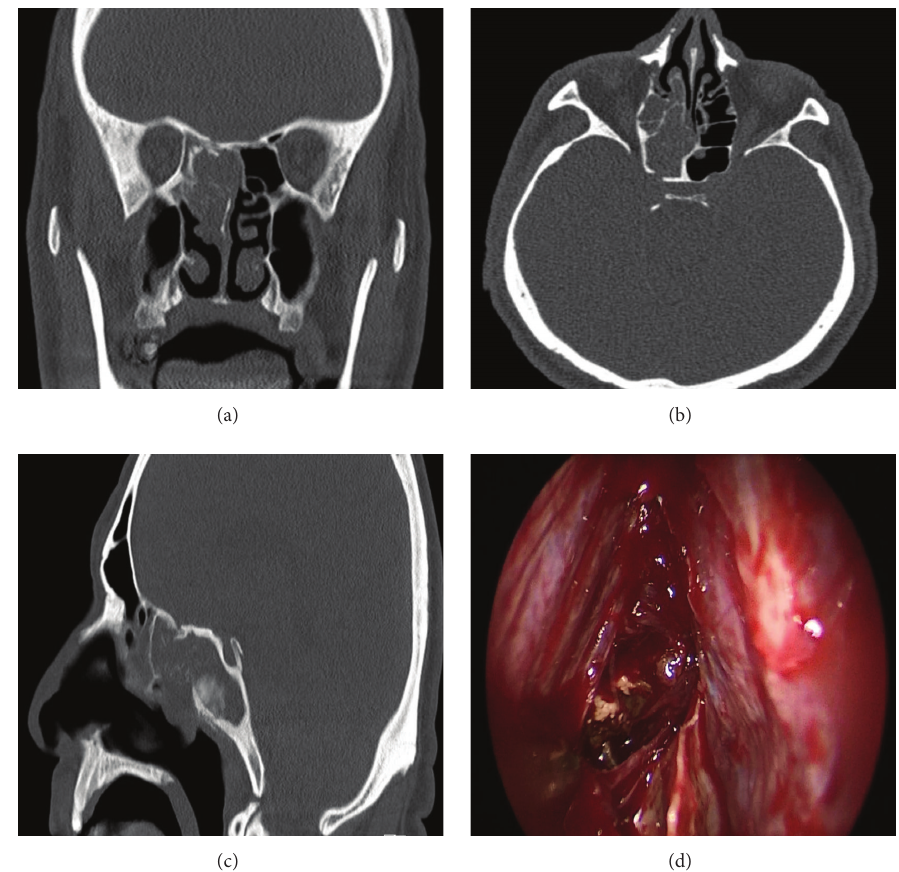
Figure 4: (a, b, and c) Paranasal sinus computed tomography of a hypodense mass filling the right sphenoid sinus (a-coronal, b-axial c-sagittal planes). (d) Endoscopic view of the caseous material filling the right sphenoid